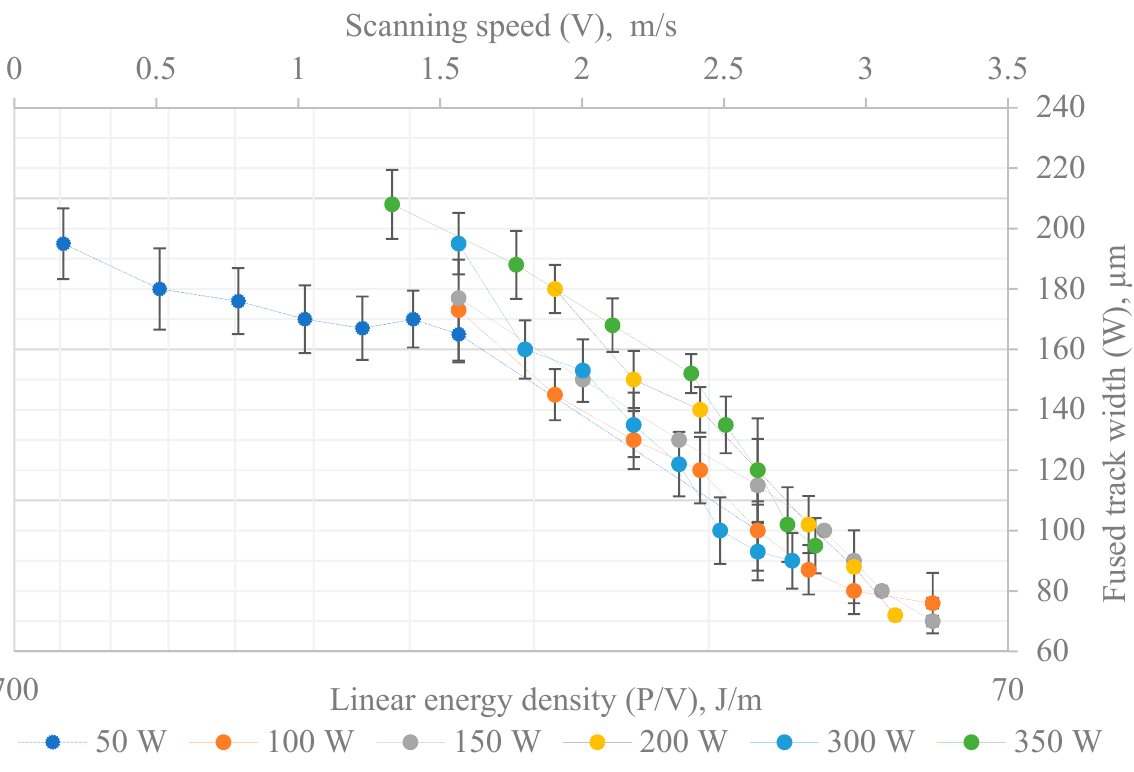
Figure 6. Relationship between linear energy density, scanning speeds and width of the tracks.